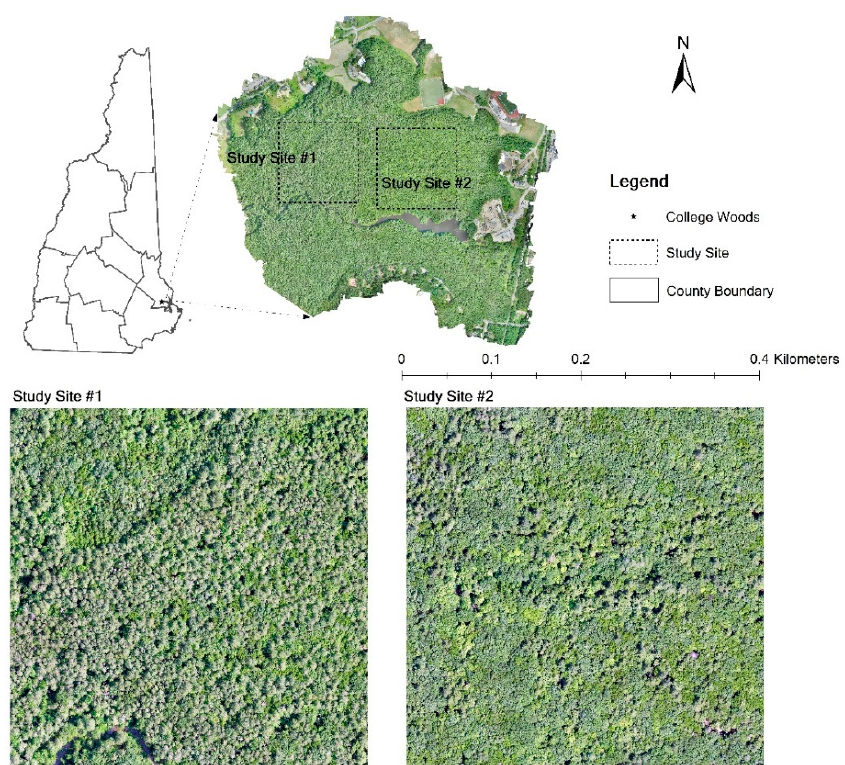
Figure 1. Study sites at College Woods, New Hampshire, USA